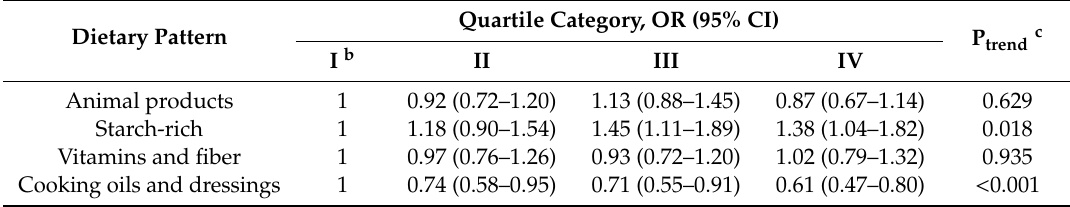
Table 5. Odds Ratios (ORs) a of renal cell carcinoma and corresponding 95% Confidence Intervals (CIs) on quartiles of factor scores from a principal component factor analysis.